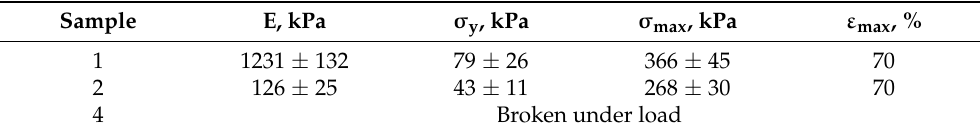
Table 3. Mechanical properties of cellulose